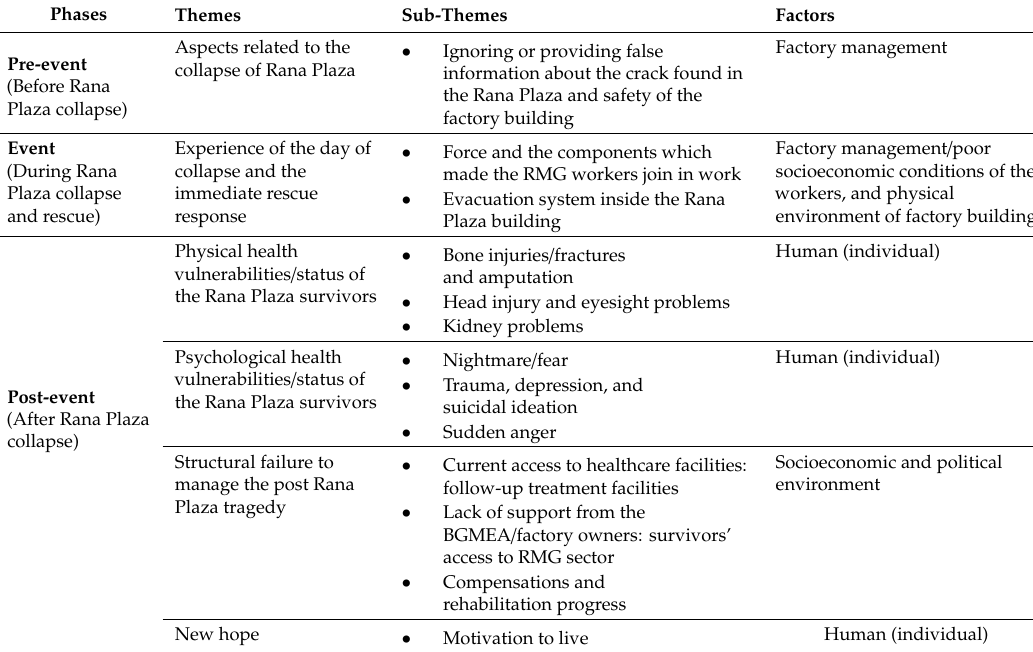
Table 2. Summary of